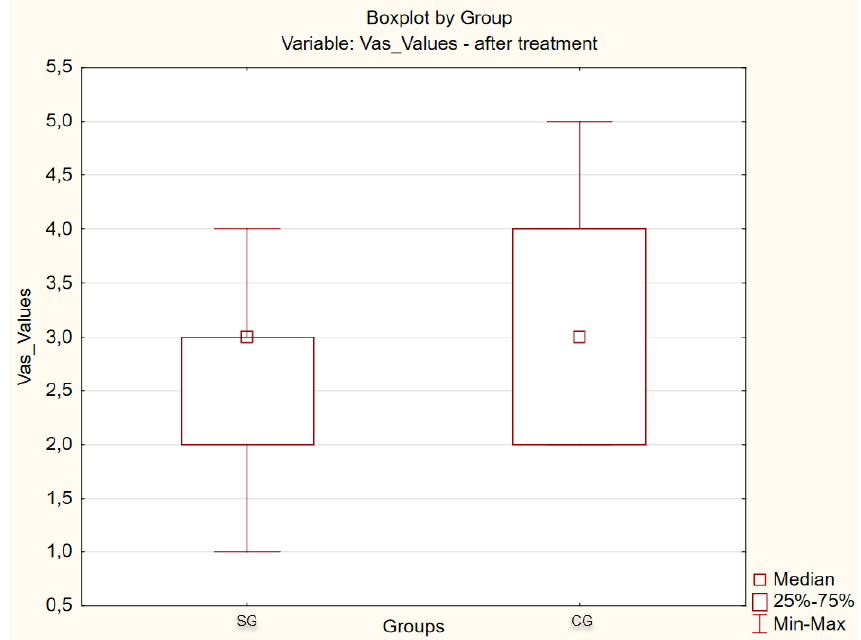
Figure 6. Results of VAS points after management.